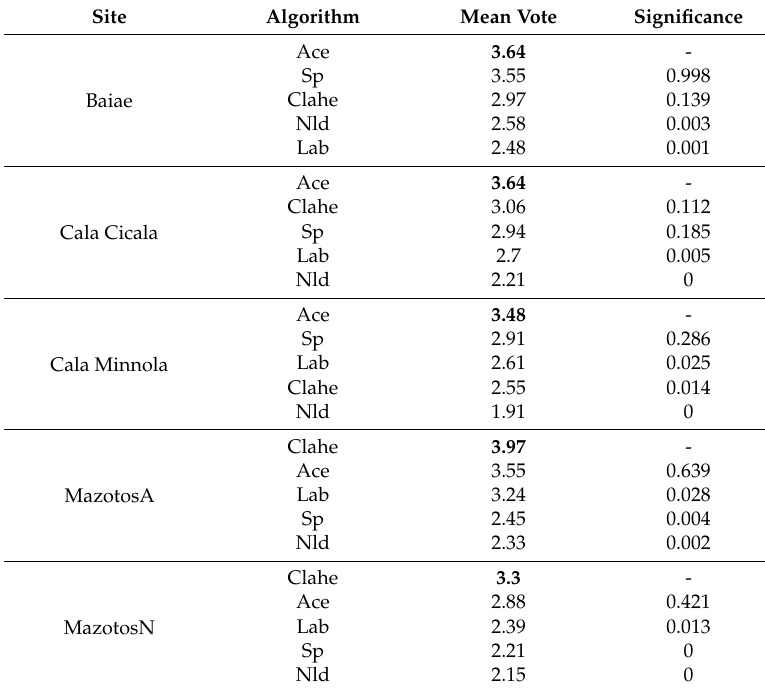
Table 10. Summary table of ANOVA